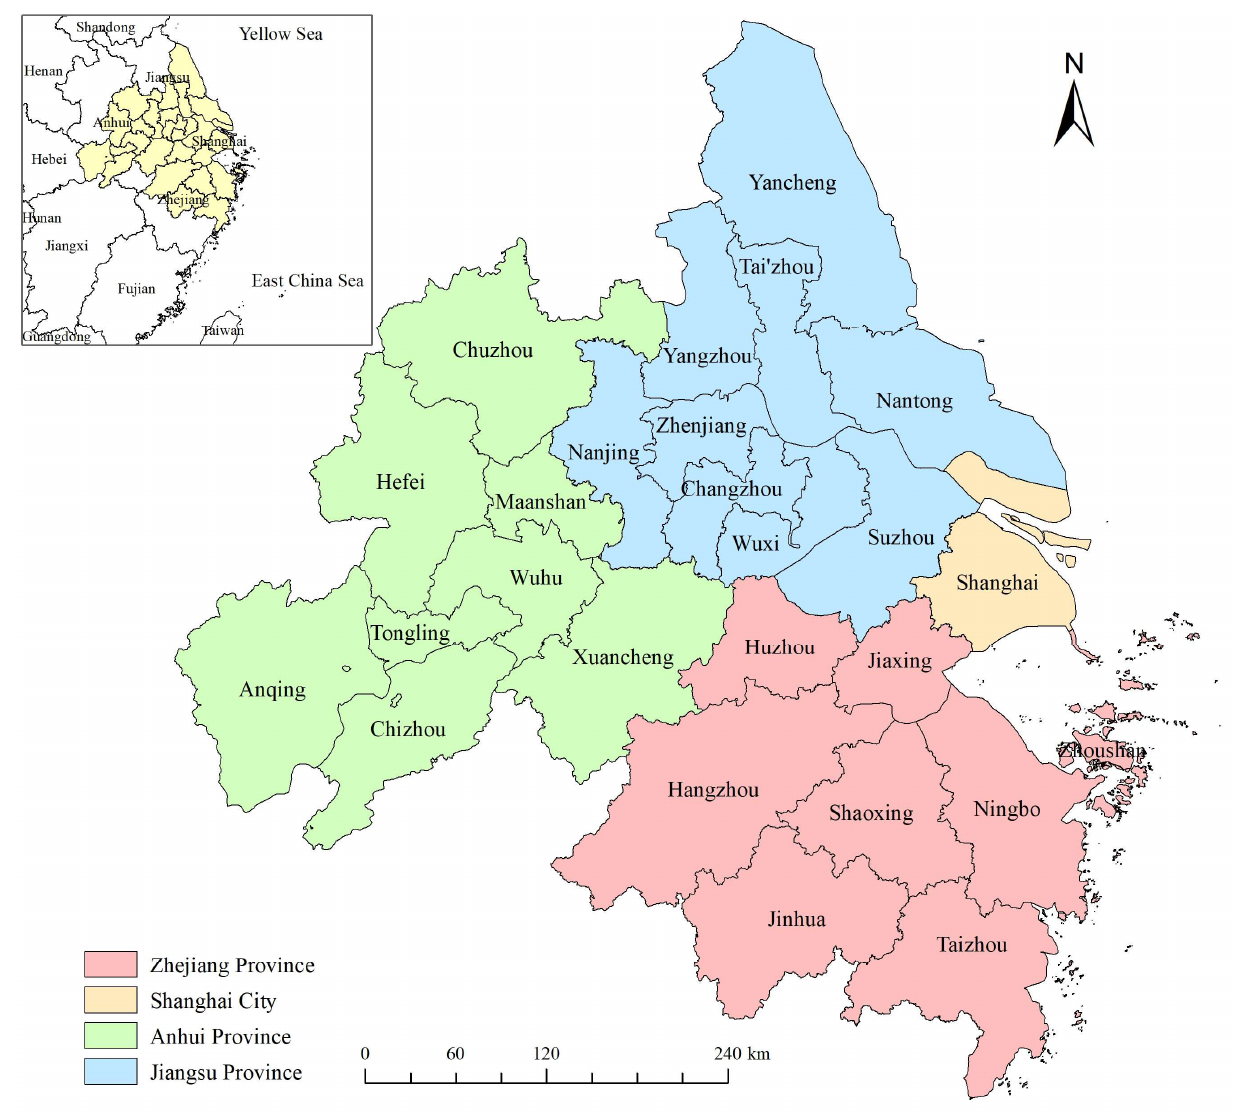
Figure 1. Location and cities of the